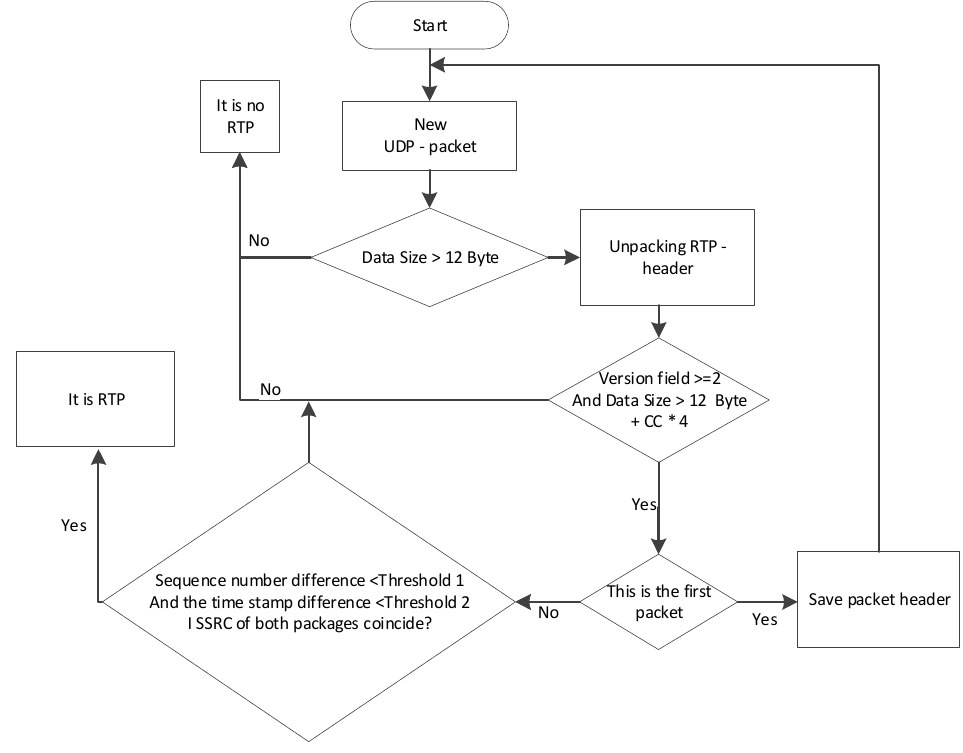
Figure 13. The algorithm of the RTP protocol detector.